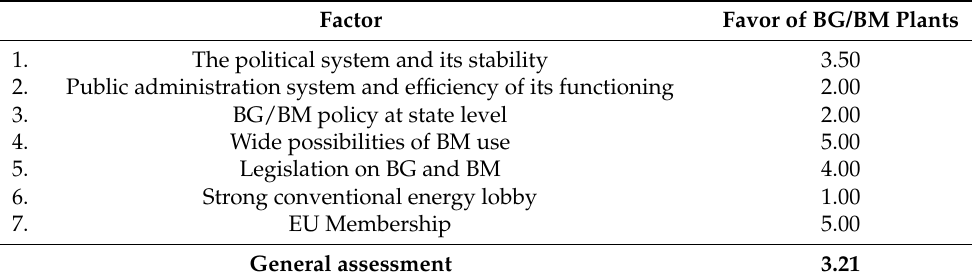
Table 4. Political environment of BG/BM plants in Poland in the context of their development